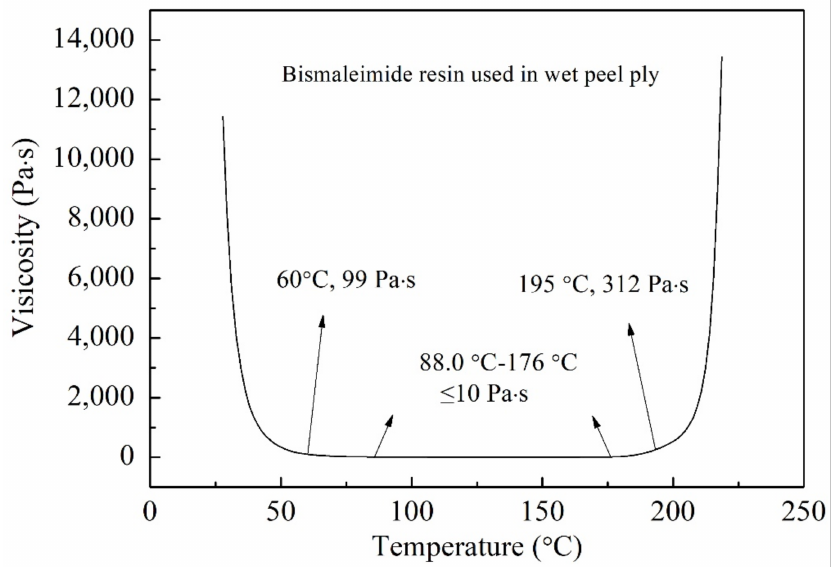
Figure 2. Viscosity–temperature curve of the matrix resin of the wet peel ply.